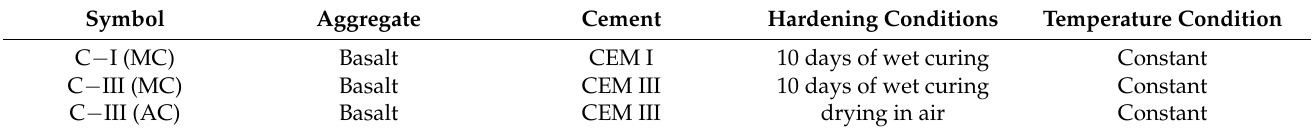
Table 1. Characteristics of concrete samples.